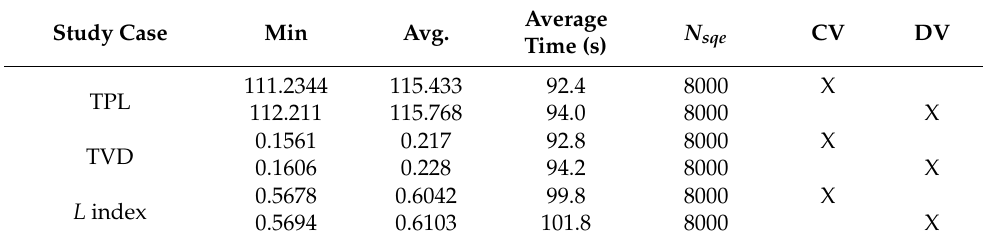
Table 14. Results obtained by the proposed method from the IEEE 118-bus